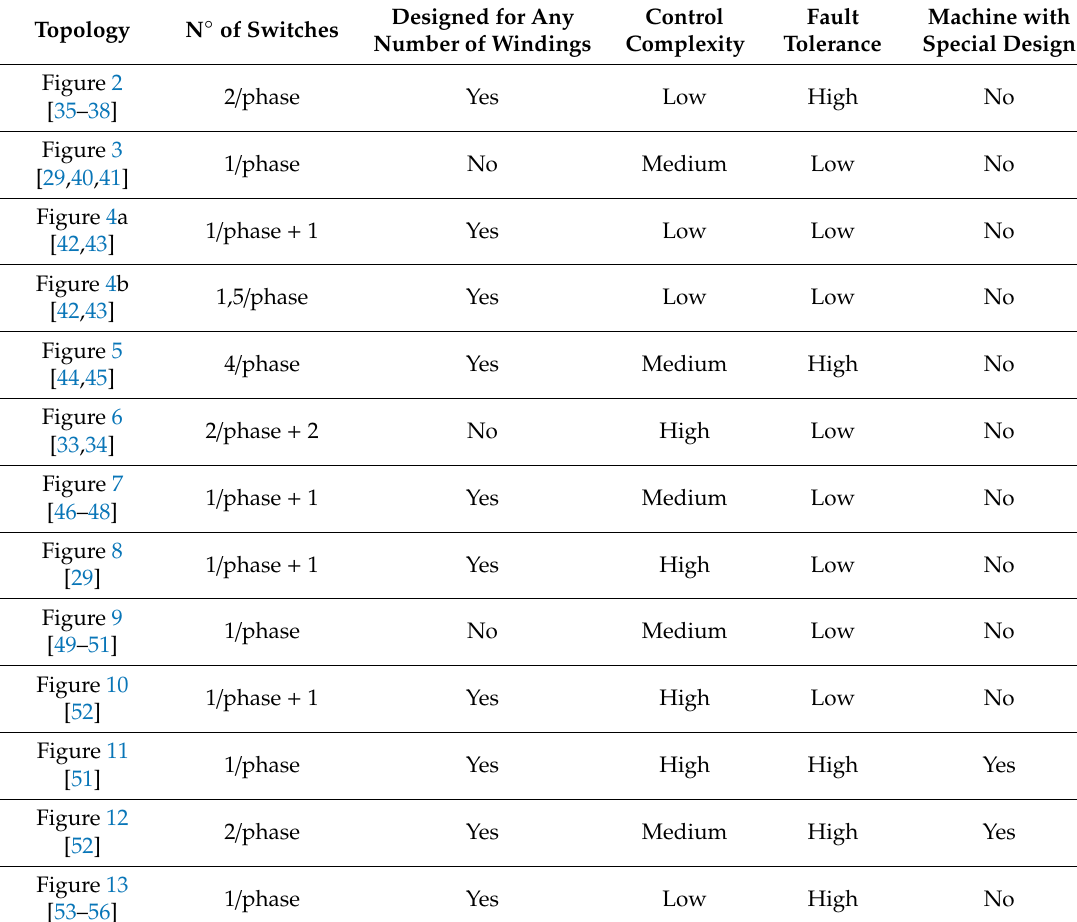
Table 1. Comparative summary of the SRM two-level